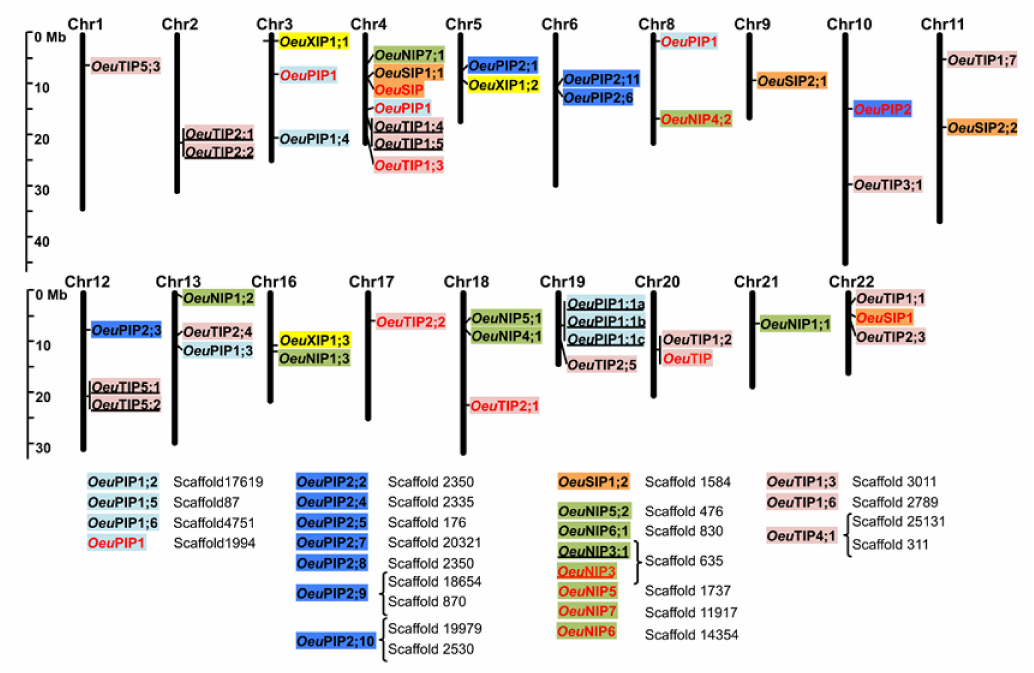
Figure 5. Genomic distribution of Oeu AQP genes on the 23 Olea europaea var. sylvestris chromosomes (except chromosomes 7, 14, 15 and 23). The di ff erent aquaporin subclasses are distinguished using di ff erent colored boxes that correspond to the color code in Table S2. The scale is in megabase pairs (Mb). Sixteen sequences could not be anchored to a specific chromosome and are specified in their sca ff old of origin. Pseudogenes are specified in red. Tandemly duplicated genes are